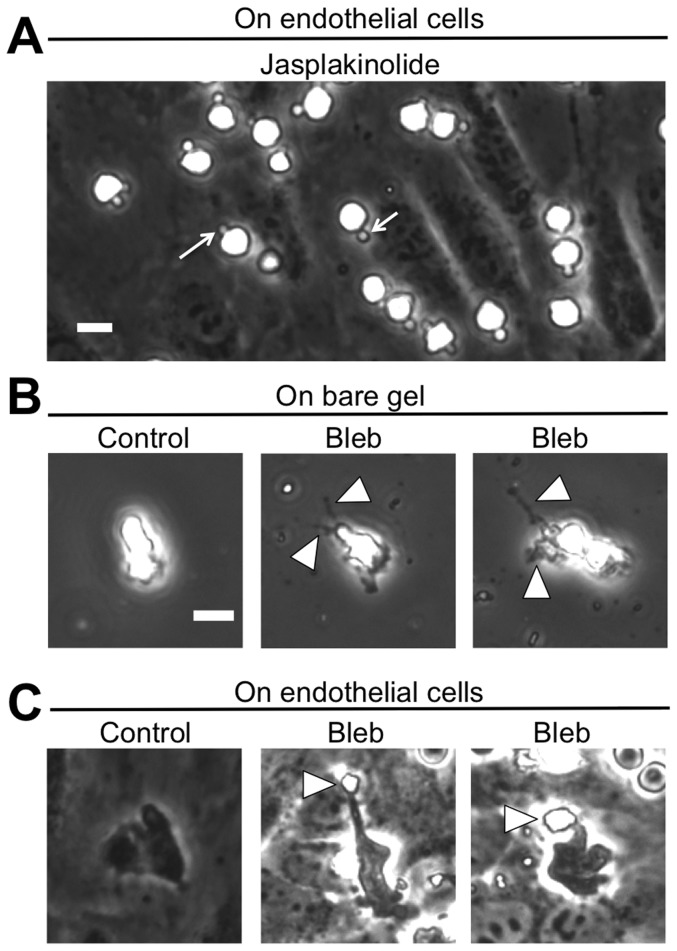
Effects of actin stabilization (via jasplakinolide) or myosin II inhibition (via blebbistatin) on neutrophil morphology.(A) Jasplakinolide-treated neutrophils are shown on a TNF-α-activated HUVEC monolayer on a 5 kPa polyacrylamide gel, approximately 20 minutes after plating neutrophils. White arrows point to protrusion structures that remain (and are not dynamic) throughout the entire timelapse. In subsequent panels, blebbistatin (“bleb”)-treated neutrophils were plated on (B) bare fibronectin-coated polyacrylamide gels (without an endothelium) and activated with 10 nM fMLF or (C) on TNF-α-activated HUVECs on a 5 kPa polyacrylamide gel. Arrowheads in panels B and C point to tails left behind by the neutrophils as it migrates along the gel (panel B) or as it transmigrates through the endothelium (panel C). Two examples of blebbistatin-treated neutrophils are given for panels B and C. Scale bar in panel B is 10 µm and applies to all images in panels A, B, and C.